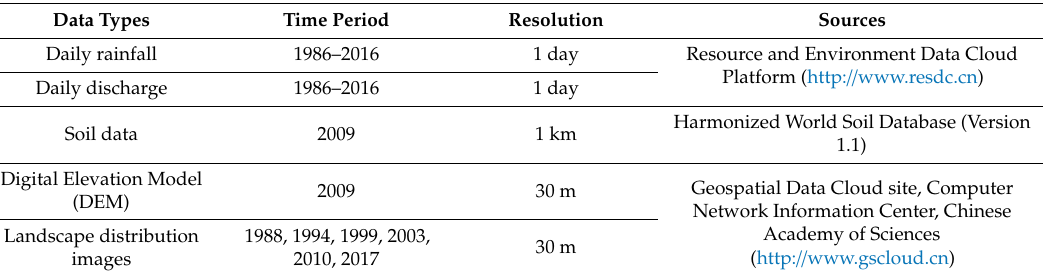
Table 1. The data used in the study.